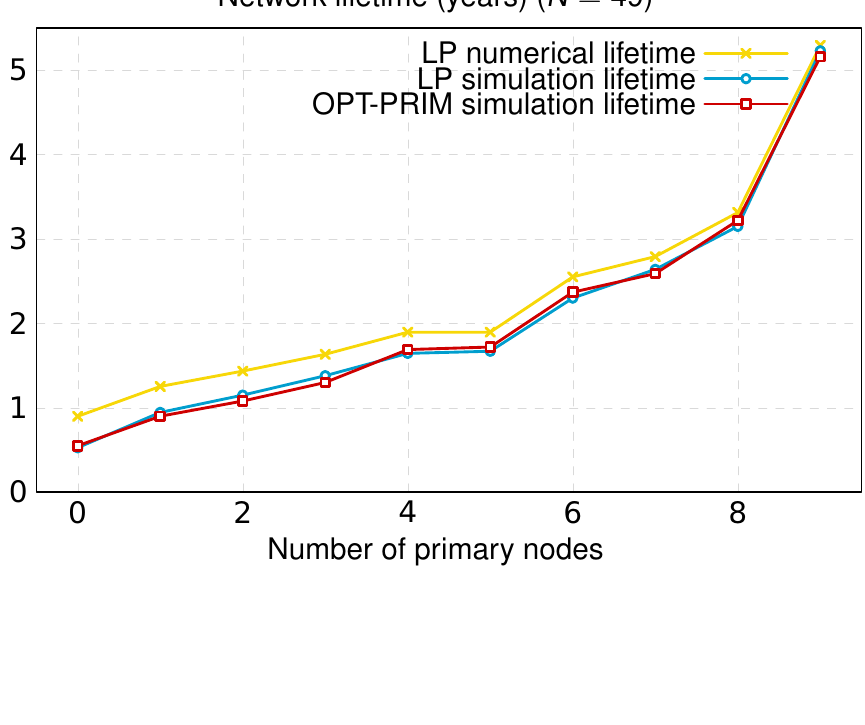
Figure 11. Average network lifetime as a function of the number of primary nodes for a WSN network of 49